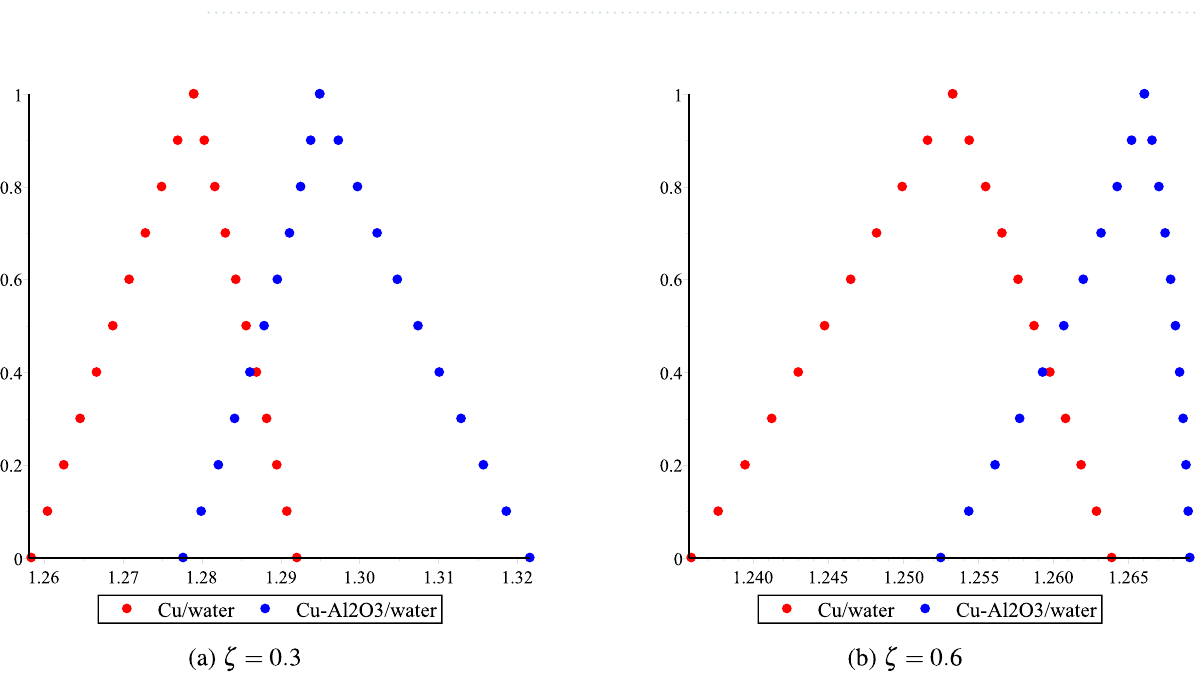
Figure 13. Effect of φ = [ 0%, 3%, 5% ] for Cu-H 2 O and Cu-Al 2 O 3 /H 2 O on fluid velocity distribution bound υ(α , δ , ζ) in ω > 0